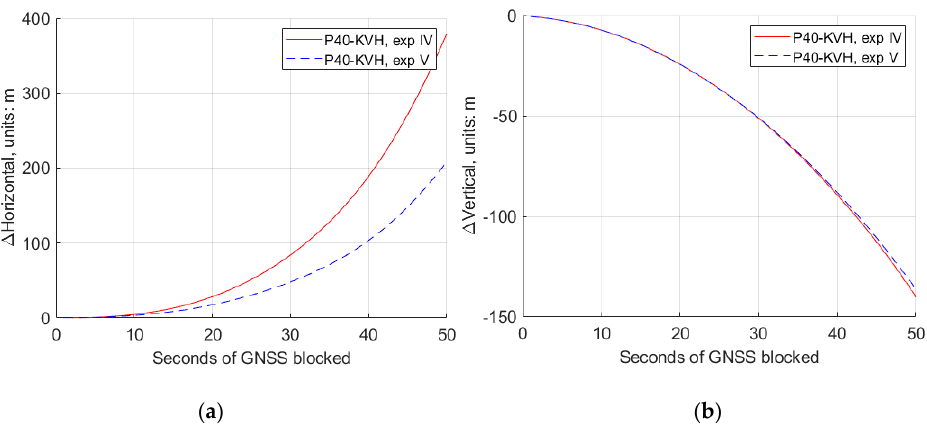
Figure 9. The horizontal and vertical position differences between GNSS/IMU-P40 (our program in a 15-state Kalman filter) and GNSS/KVH coupled navigation (IE software), with the conventional Kalman filter (experiment IV) and the modified Kalman filter (experiment V). ( a ) Horizontal position differences; ( b ) vertical position differences.